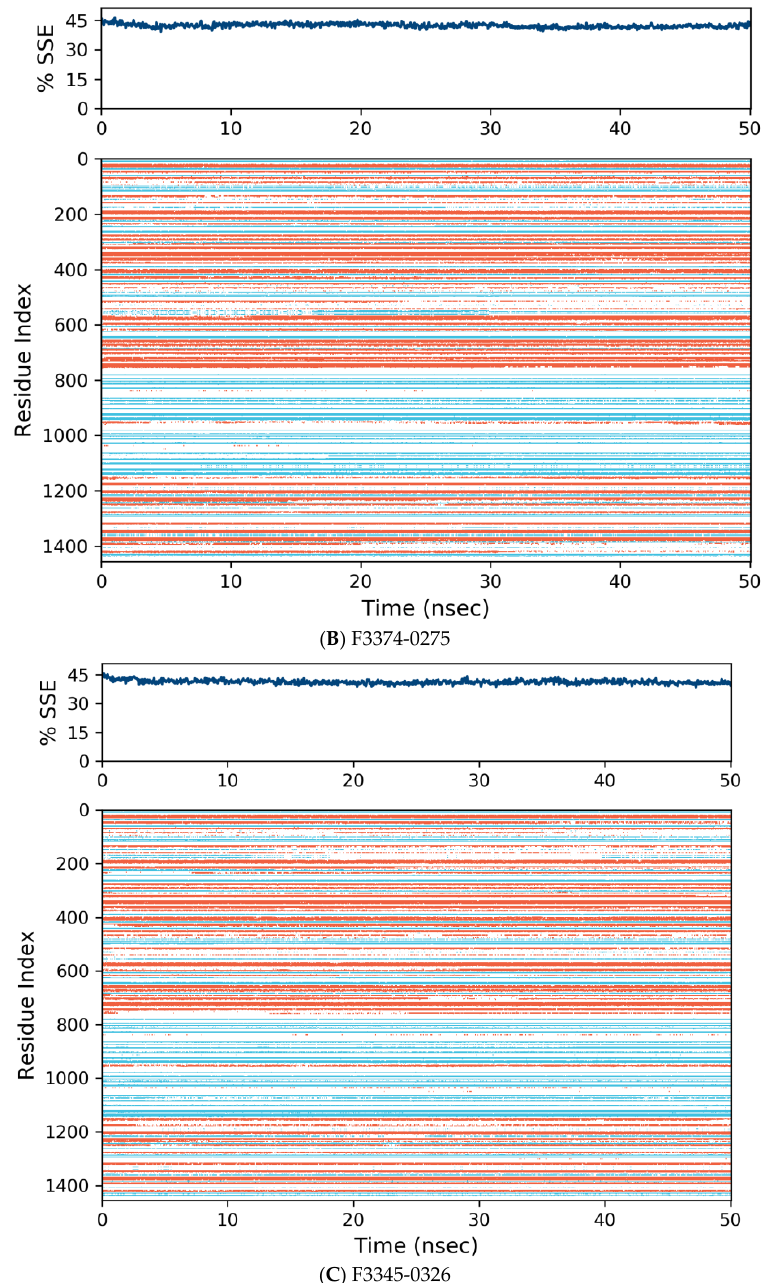
Figure 7. Distribution of protein secondary structure components by residue index across the protein structure. Red denotes alpha helices, and blue denotes beta-strands. The majority of the essential ligand – protein interactions determined by MD are hy- drogen bonds and hydrophobic interactions, as illustrated in Figure 5. The stacked bar graphs have been normalized over the pathway: therefore, a value of 1.0 indicates that for 100% of the simulation time the particular interaction was conserved Figure 8. Values above 1.0 are likely to be achieved, as some protein residues could have multiple contacts of the same subtype with the ligand.